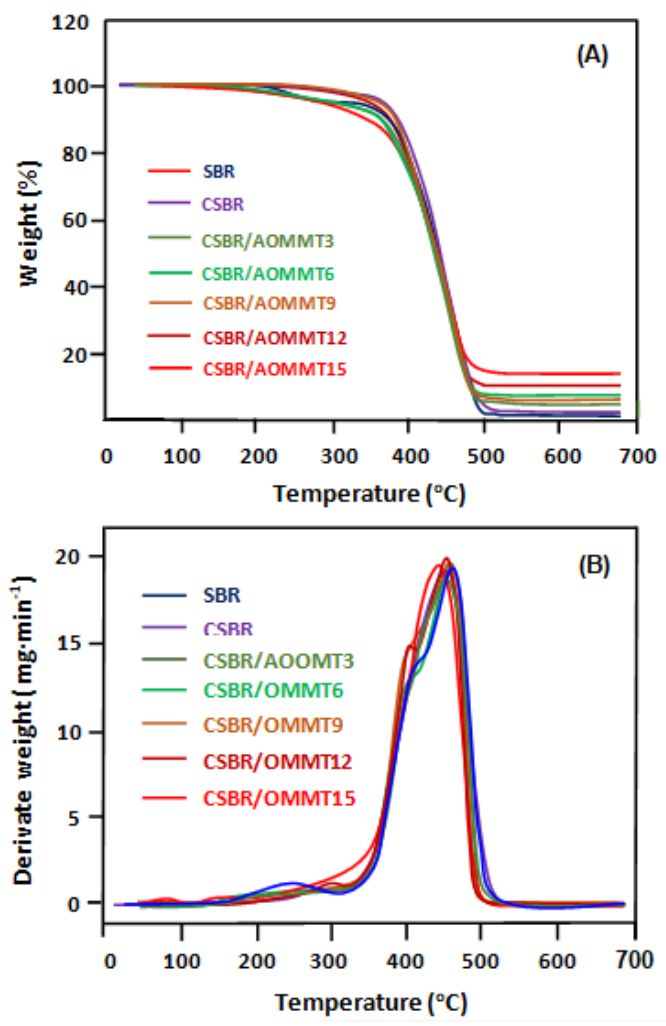
Figure 6. TGA ( A ) and DTG ( B ) thermograms of SBR, CSBR and CSBR/OMMT nanocomposites with different OMMT contents.